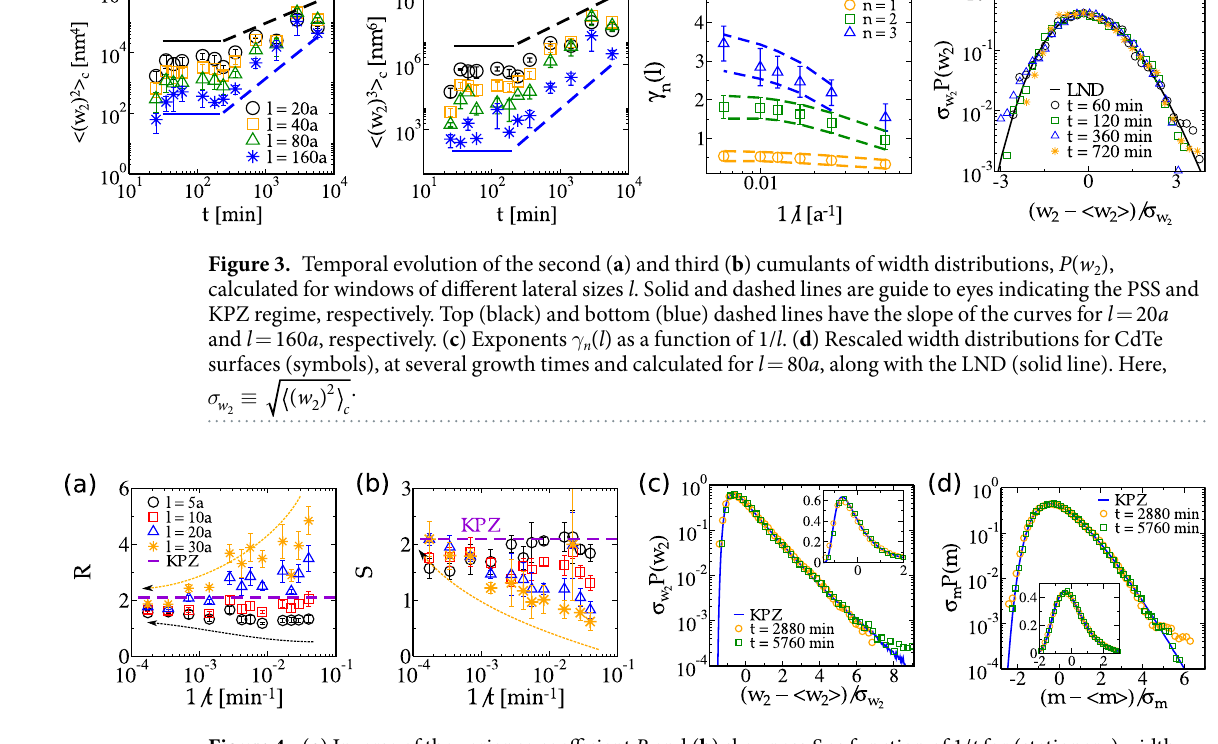
Figure 4. ( a ) Inverse of the variance coefficient R and ( b ) skewness S as function of 1/ t for (stationary) width distributions, for several window sizes l . Rescaled ( c ) width [ P ( w 2 )] and ( d ) maximal height [ P ( m )] distributions, for CdTe (symbols) and 2D-KPZ models (solid blue lines). Insets show the same data in log-linear 2 is the standard deviation of X = w scale. Here, σ ≡ X 2 , m X c